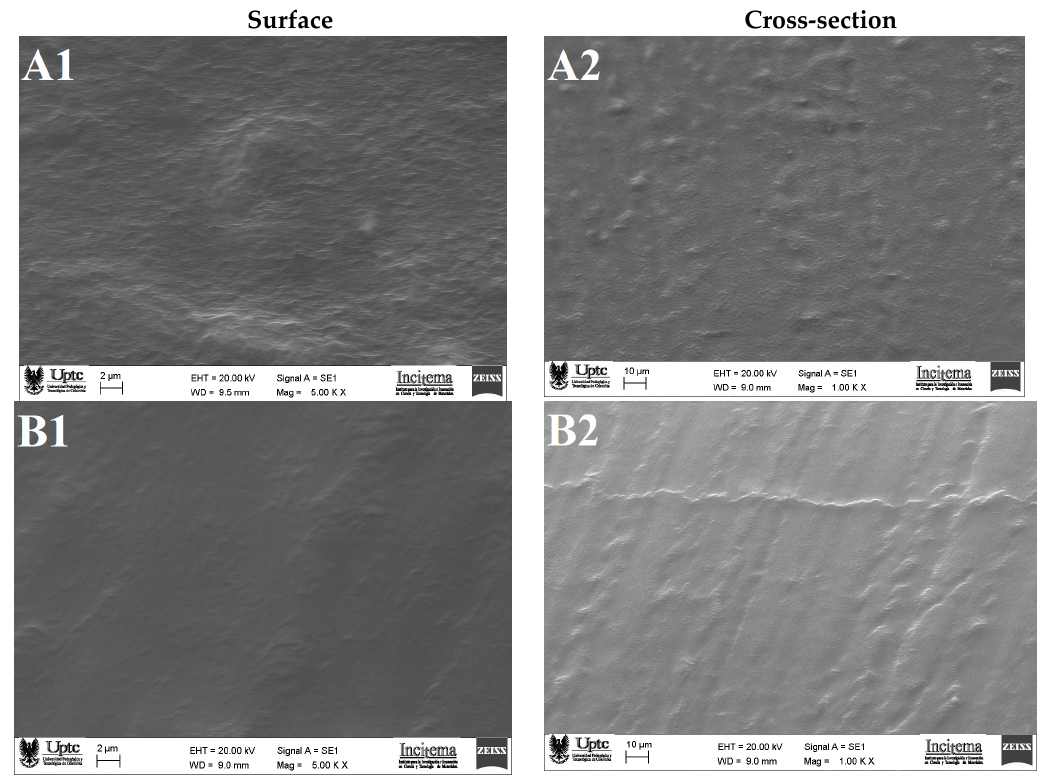
Figure 2. Representative micrograph images of capsule surfaces (5.00 KX) and cross-section areas (1.00 KX): ( A ) composite capsule and ( B ) control capsule.